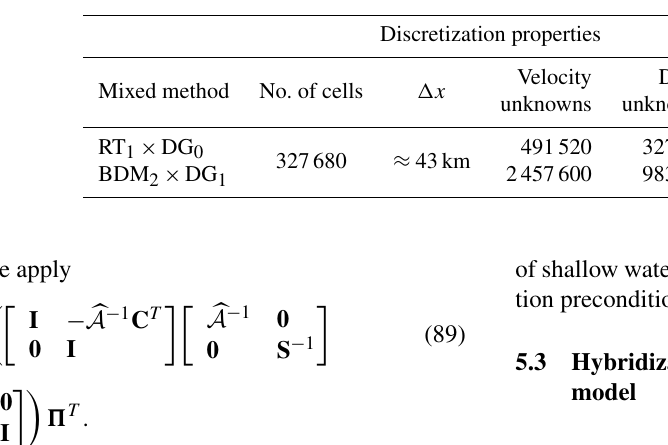
Table 2. The number of unknowns to be determined are summarized for each compatible finite element method. Resolution is the same for both